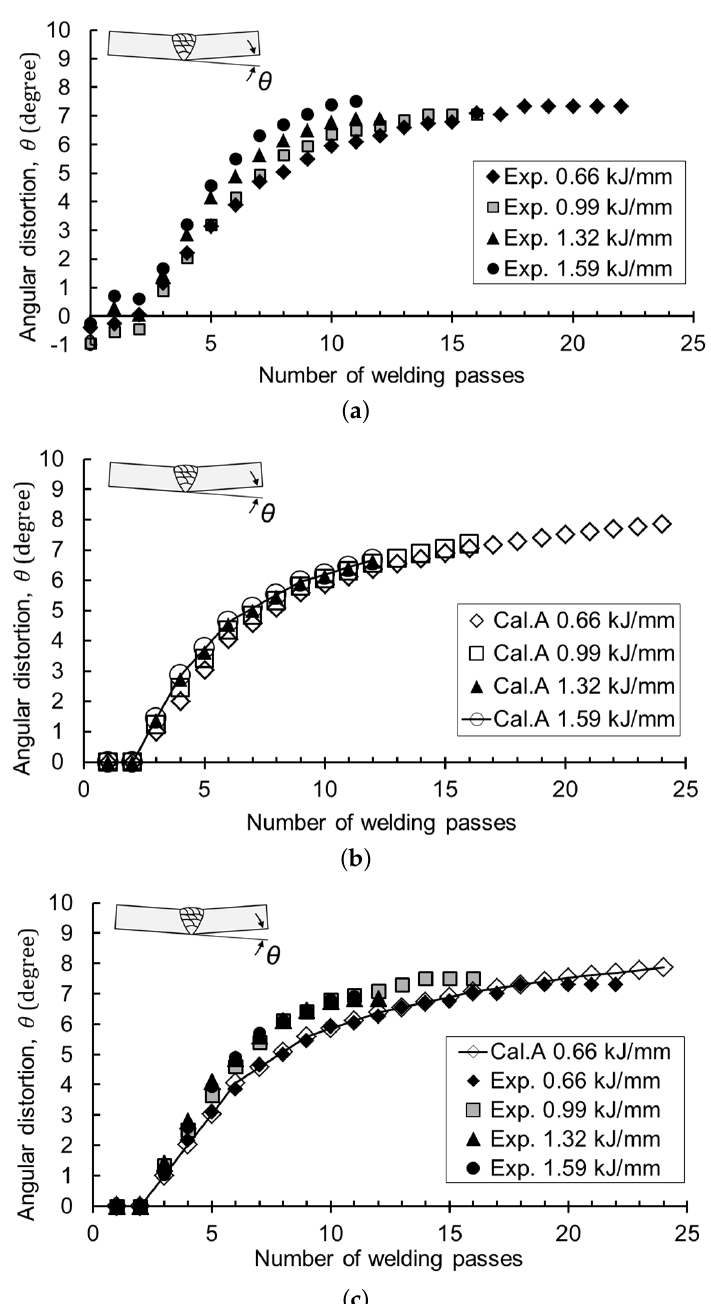
Figure 10. Result of angular distortion in V-groove multi-layer welding: ( a ) experimental (Exp.) results; ( b ) calculation (Cal.) results; ( c ) comparison of the experiment with